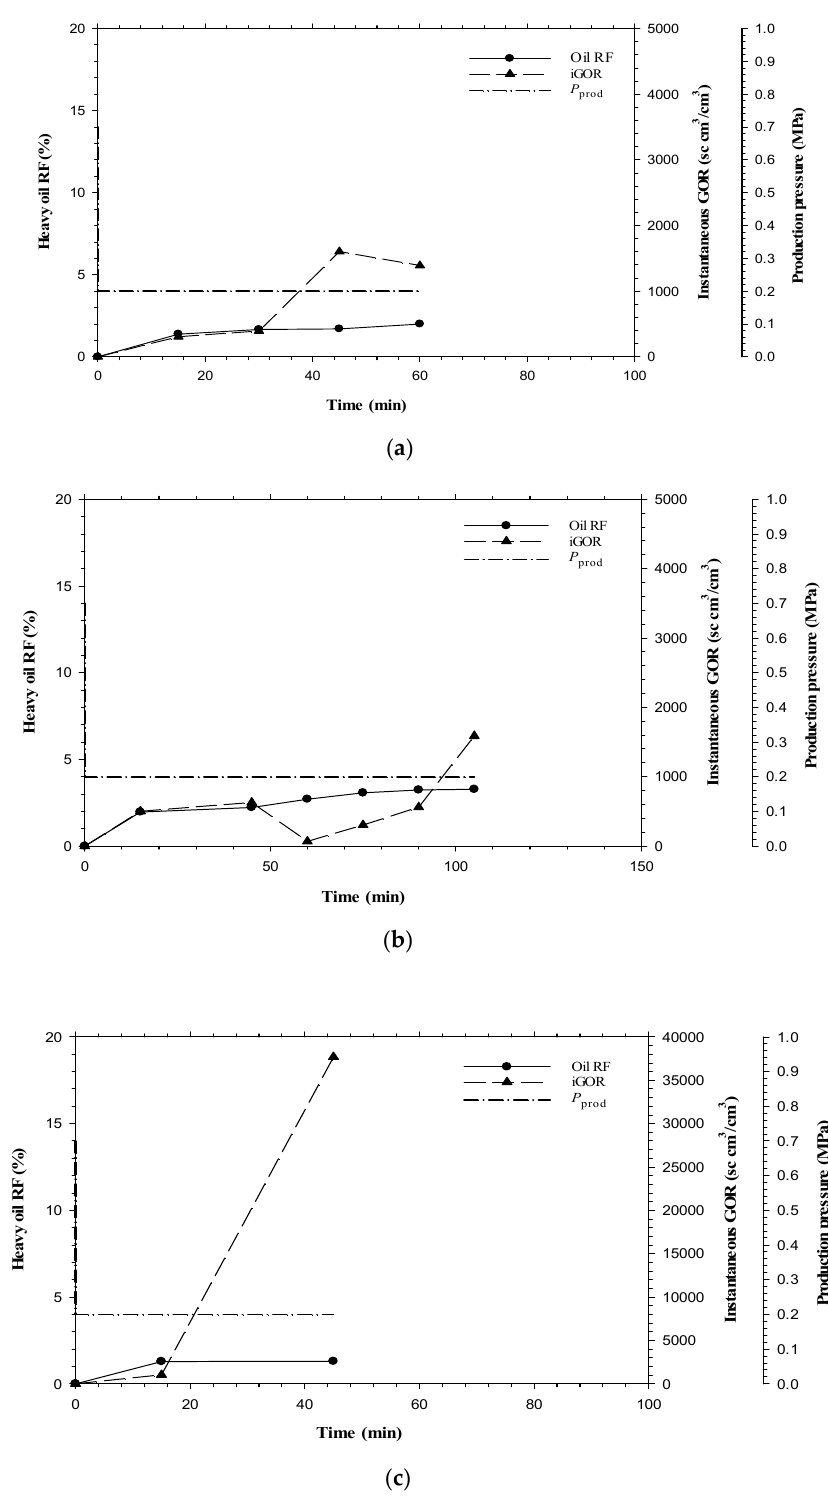
Figure 5. Measured heavy oil recovery factors (RFs), instantaneous gas-oil ratios (iGORs) and production pressures ( P prod ) in C 3 H 8 -CSI process at ∆ P EOR = 0.5 MPa (Test #1) ( a ) Cycle #1; ( b ) Cycle #2; and ( c ) Cycle #3.